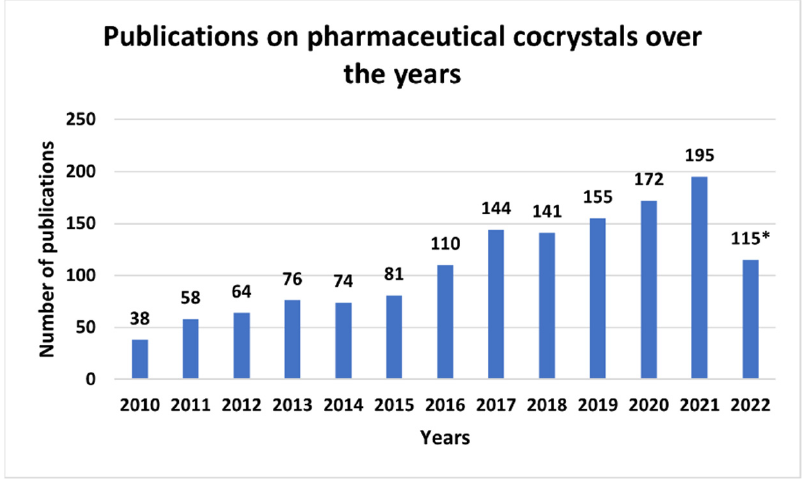
Figure 2. Publications on pharmaceutical cocrystals over the years.